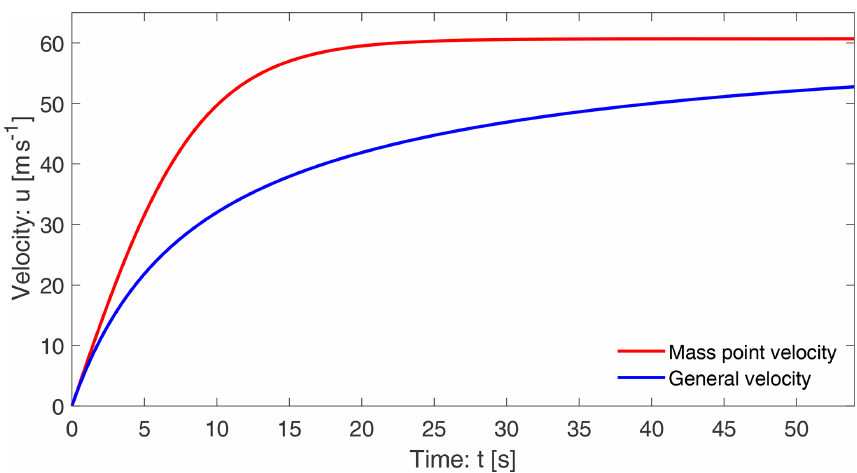
Figure 7. The velocity profiles for a landslide with the mass point motion as given by Eq. (11) and the motion including the internal deformation as given by the general solution (Eq.